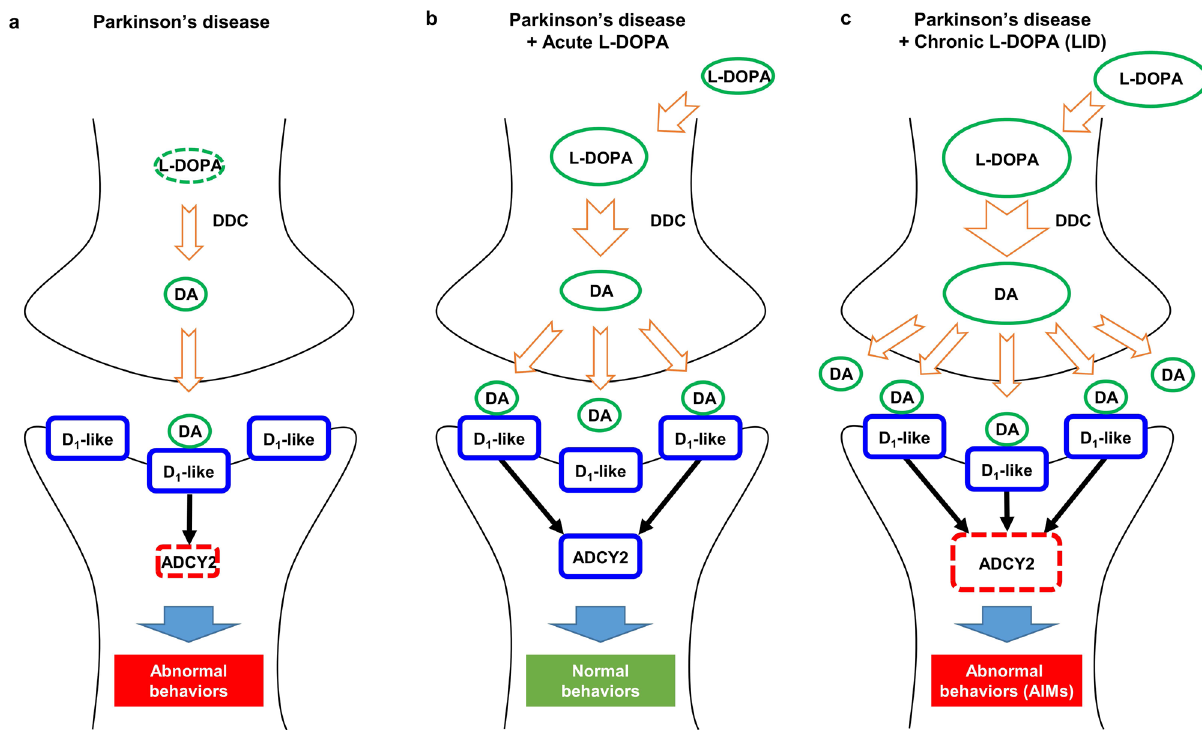
Fig. 8 A proposed mechanistic model of LID in Drosophila . a Schematic illustration of PD pathogenesis. Dampened DA production in the presynaptic terminals leads to depression of postsynaptic D1-like receptor-ADCY2 signaling causing motor de fi cits. b Schematic illustration of acute L-DOPA-mediated amelioration of PD. Acute L-DOPA administration normalizes presynaptic DA production and the postsynaptic signaling is restored, resulting in normal motor behaviors. c Schematic illustration of LID pathogenesis. Chronic L-DOPA administration causes excessive DA conversion in the presynaptic terminals and the excessive DA abnormally boosts of postsynaptic D1-like receptor-ADCY2 signaling, leading to LID. DA, dopamine; D1-like, D1-like family receptors; DDC, DOPA